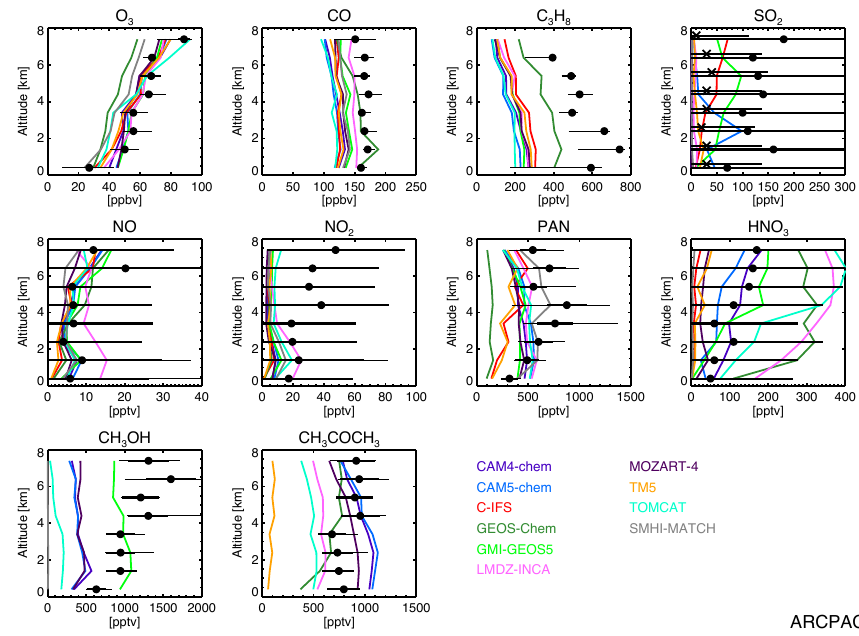
Figure 17. As Fig. 16, for ARCPAC NOAA P3